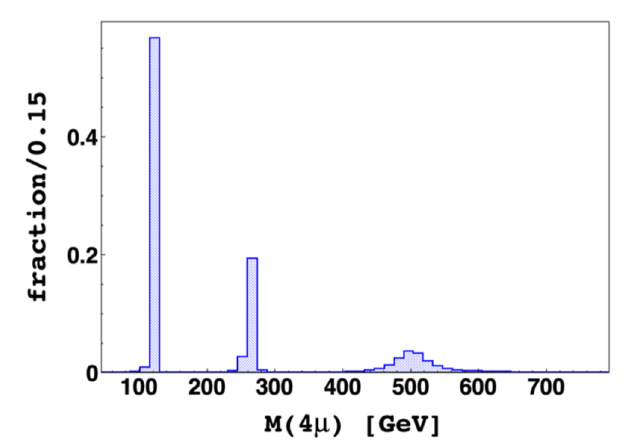
Figure 8 . Distribution of the total invariant mass of the four muon final state from the process pp → H i → ZZ → 4 µ , from an inclusive simulation of the signal sample with 20M events, including a fast detector simulation with